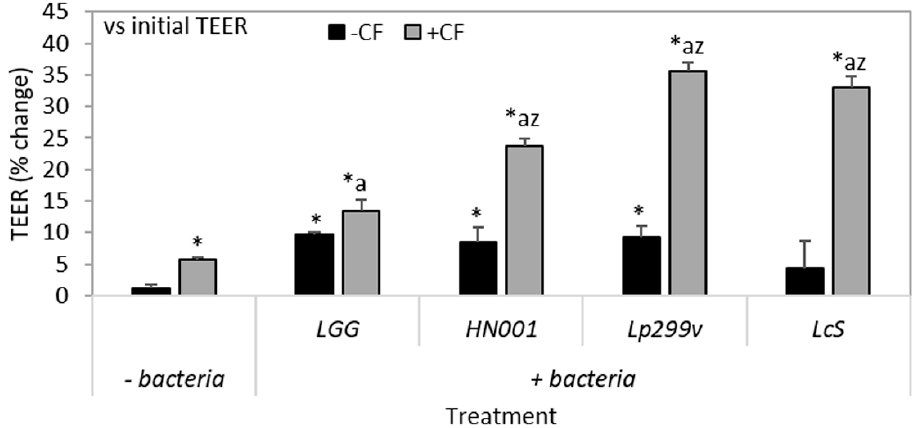
Figure 4. Influence of a carbohydrate fraction (CF) from caprine milk (CF; 4 mg/mL) and probiotic bacteria either alone or in combination on trans-epithelial electrical resistance (TEER) of 90:10 Caco-2:HT29–MTX co-cultures. The change in TEER as the percentage change after 3 h compared with initial TEER. Values are means ( ± SEM) for three experiments (three samples per treatment per experiment); n = 3. * = Significantly different ( P < 0.05) to untreated monolayers; a = significantly different ( P < 0.05) to CF treated monolayers; and z = significantly different ( P < 0.05) to respective bacteria only treated monolayers. UNT = untreated; LGG = L. rhamnosus GG; HN001 = L. rhamnosus HN001; Lp299v = L. plantarum 299v and LcS = L. casei Shirota.